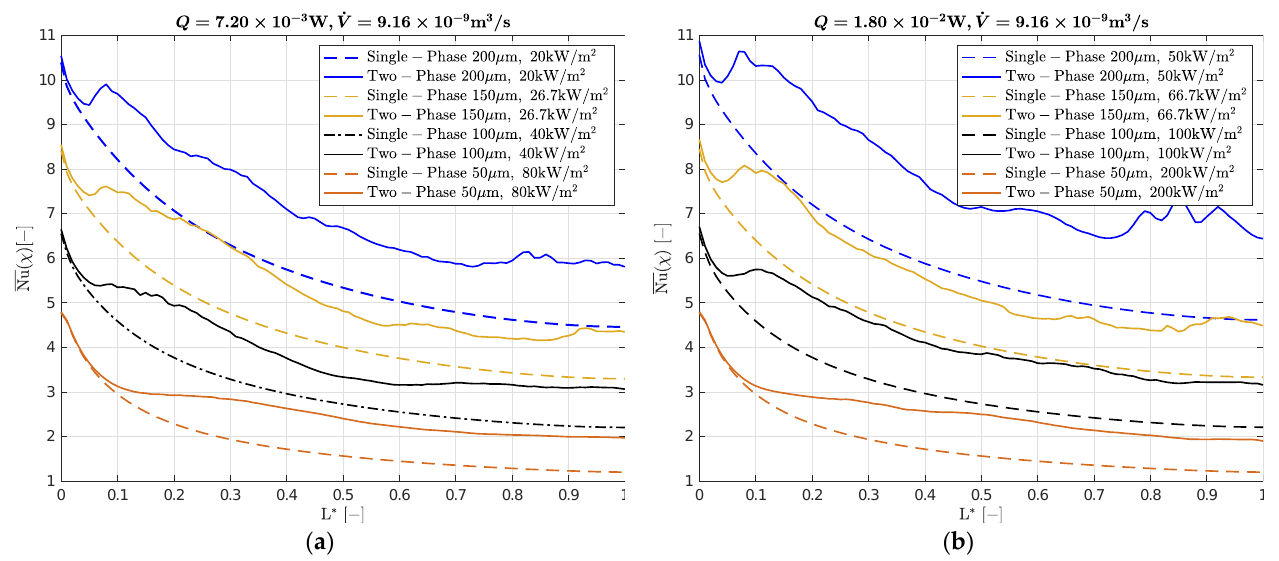
Figure 4. Influence of hydraulic diameter on time-averaged local Nusselt number on both single and two-phase simulations on constant heat transfer of 7.20 × 10 − 3 W ( a ) and 1.80 × 10 − 2 W ( b ) and constant volumetric flow rates and varying heat and mass fluxes. Table 5. Comparison of the and percentage difference between single-phase and two-phase results for the examined Q and D h